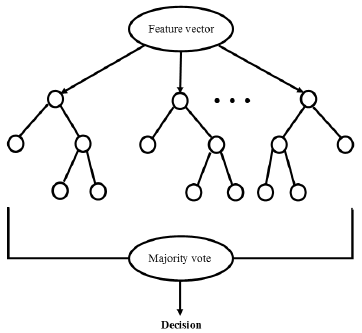
Figure 5: Structure of the random forest classifier.